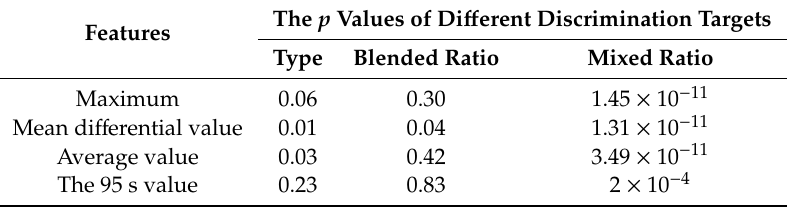
Table 3. Analysis of variance (ANOVA) for feature di ff erence analysis.